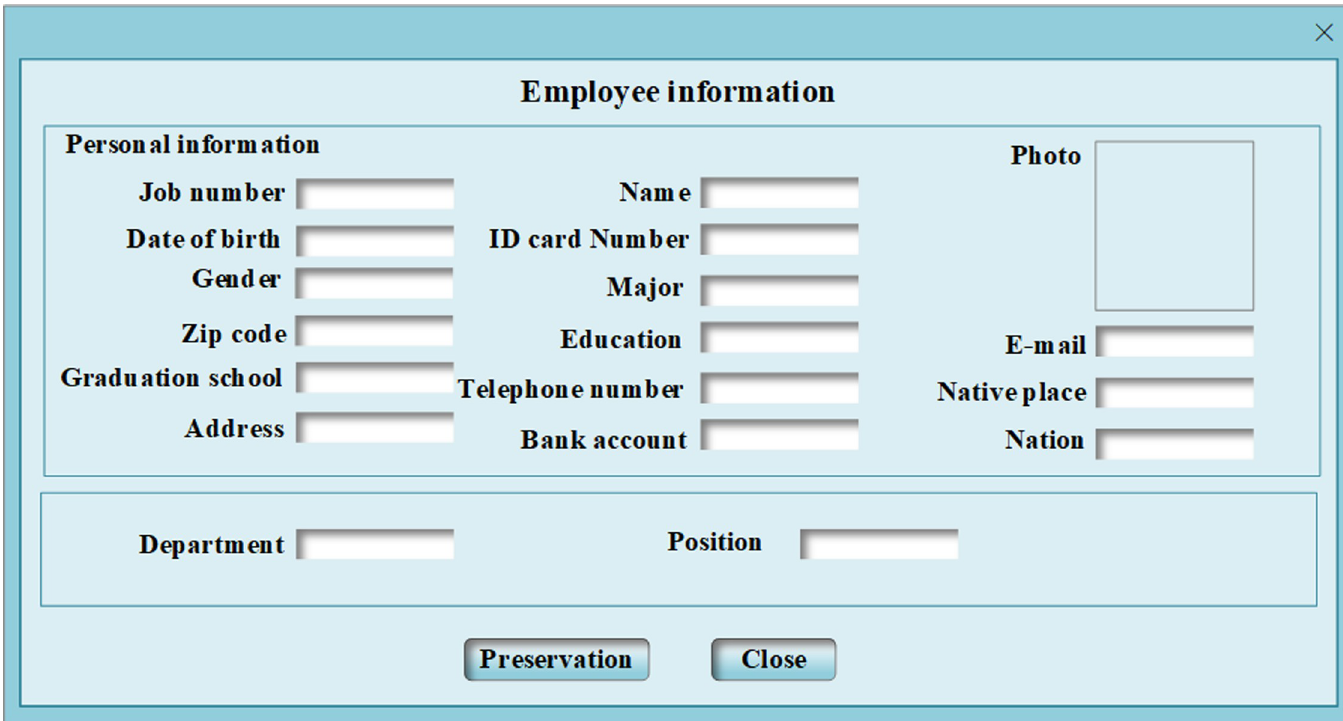
Fig 12. Realization effect of human resource